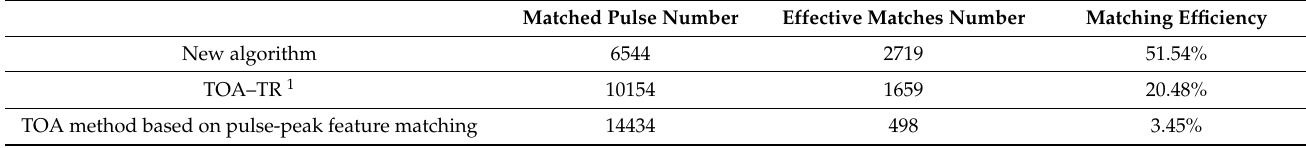
Table 6. Matching efficiency of the new algorithm, TOA–TR method and TOA method based on pulse-peak feature matching.